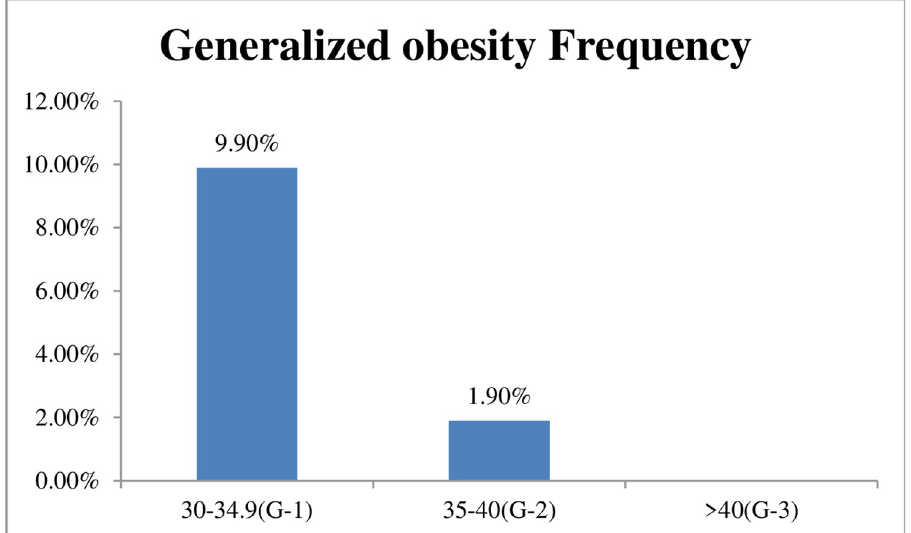
Fig 1. The different grades of obesity among the study